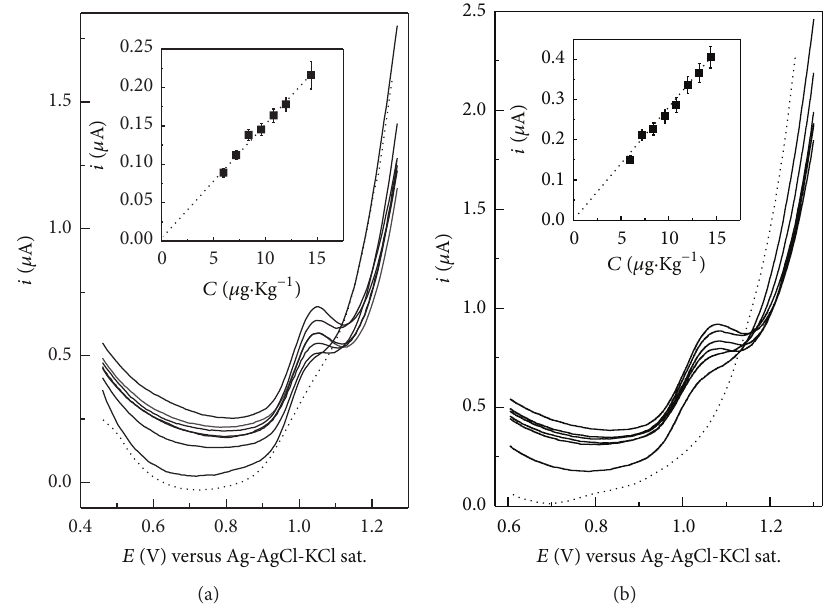
Figure 5: (a) Differential pulse and (b) square wave voltammograms at MIPpy/GCE sensor for different concentrations of FXN in milk in phosphate buffer solution (0.2 M, pH 4.7), dotted line: blank milk sample. Insets: calibration curves. Other conditions are shown in Figure